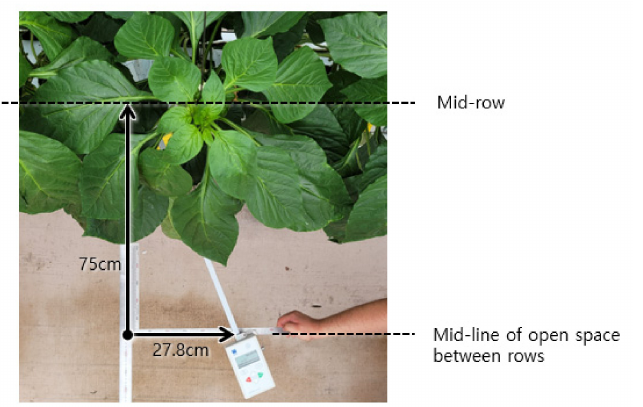
Figure 9. Photo representation of the measurement method of LAI. Regarding crop rows in the greenhouse, the probe of the ceptometer extended from the middle of the open space to the mid-row of the